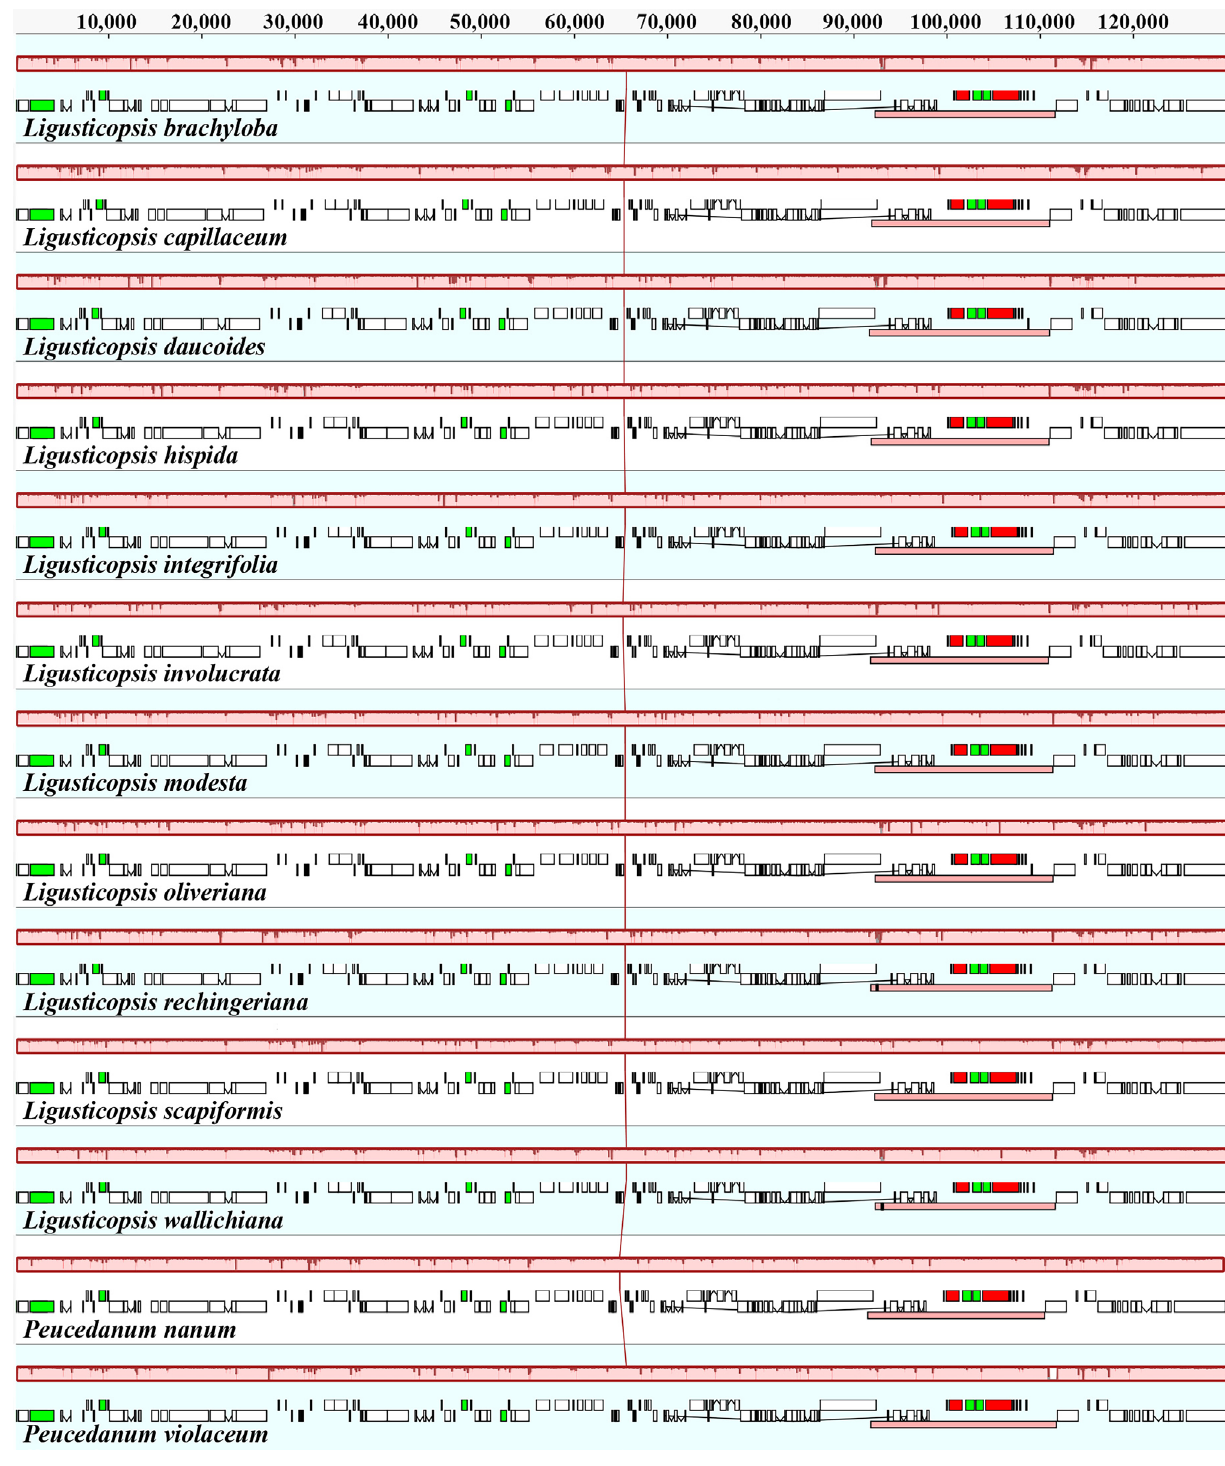
Figure 6. Mauve alignment of thirteen plastomes.